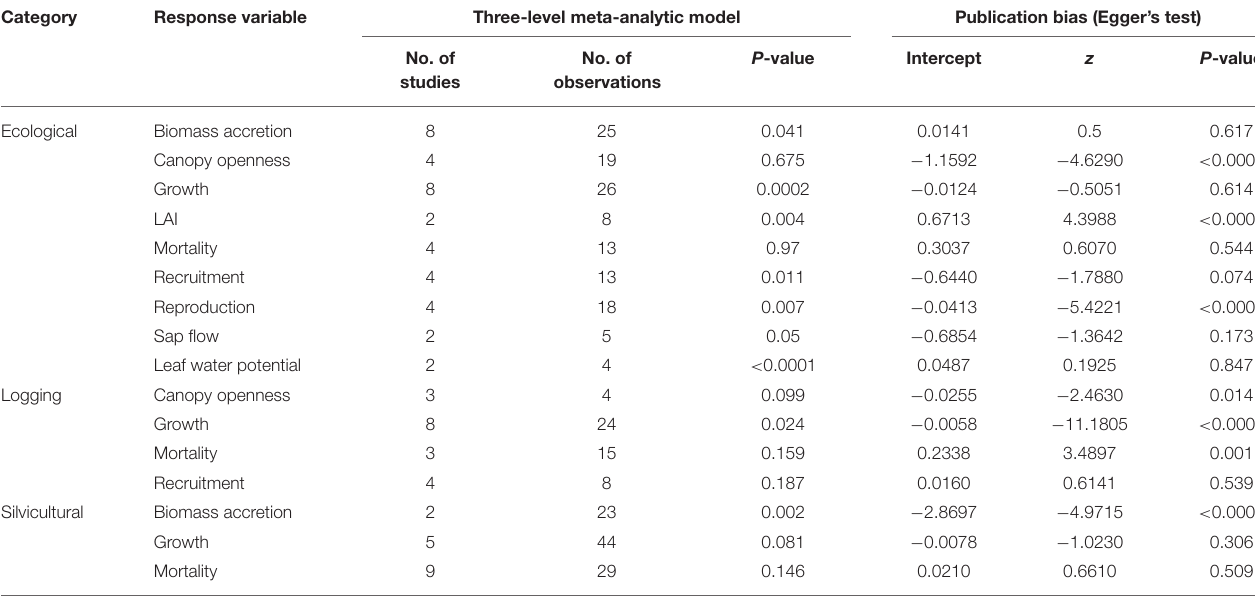
TABLE 1 | The number of studies, observations per study, and results from a meta-analysis and assessment of publication bias of 50 liana removal experiments in tropical and subtropical forests worldwide.